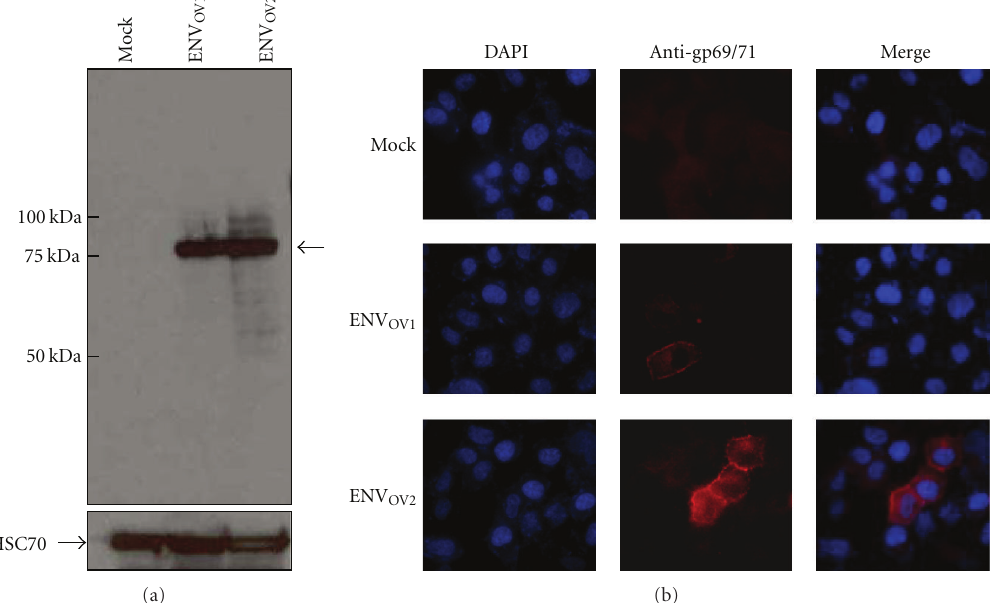
Figure 2: Coding potential and membrane localization of ENV OV1 and ENV OV2 polypeptides . (a) The coding potential of the ENV OV1 and ENV OV2 polypeptides wasconfirmed by overexpression followed by Westernblot analysisusing antibody againstRauscher MuLV gp69/71 env polypeptide. (b) The cellular distribution of the overexpressed ENV OV1 and ENV OV2 polypeptides was examined by immunocytochemistry using antibody against Rauscher MuLV gp69/71 polypeptide, and their membrane staining pattern was evident. The cells transfected with a blank plasmid serves as a negative control (mock). DAPI (4 (cid:3) ,6-diamidino-2-phenylindole).